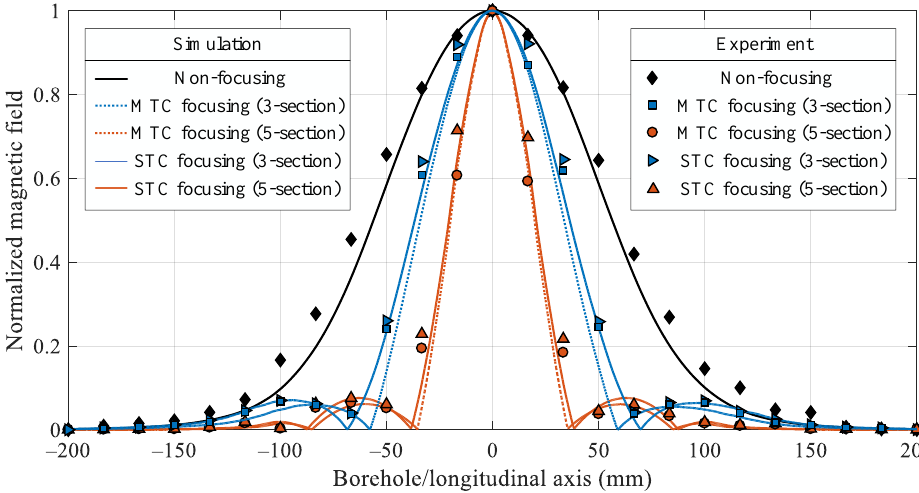
Figure 8. Experimental and simulation results for MF with the five-section STC.